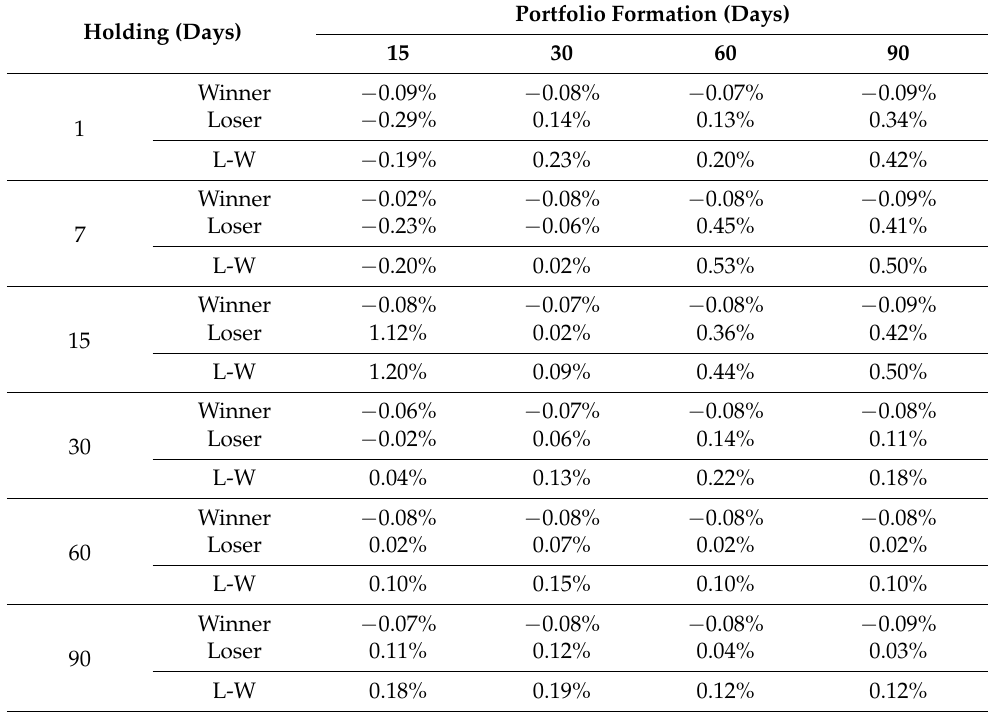
Table 5. Risk-adjusted contrarian